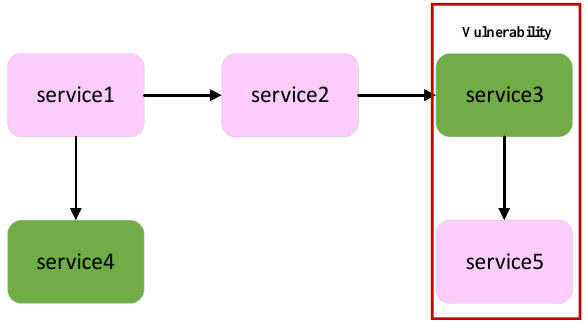
Figure 2. Graphic example of Definition 4.